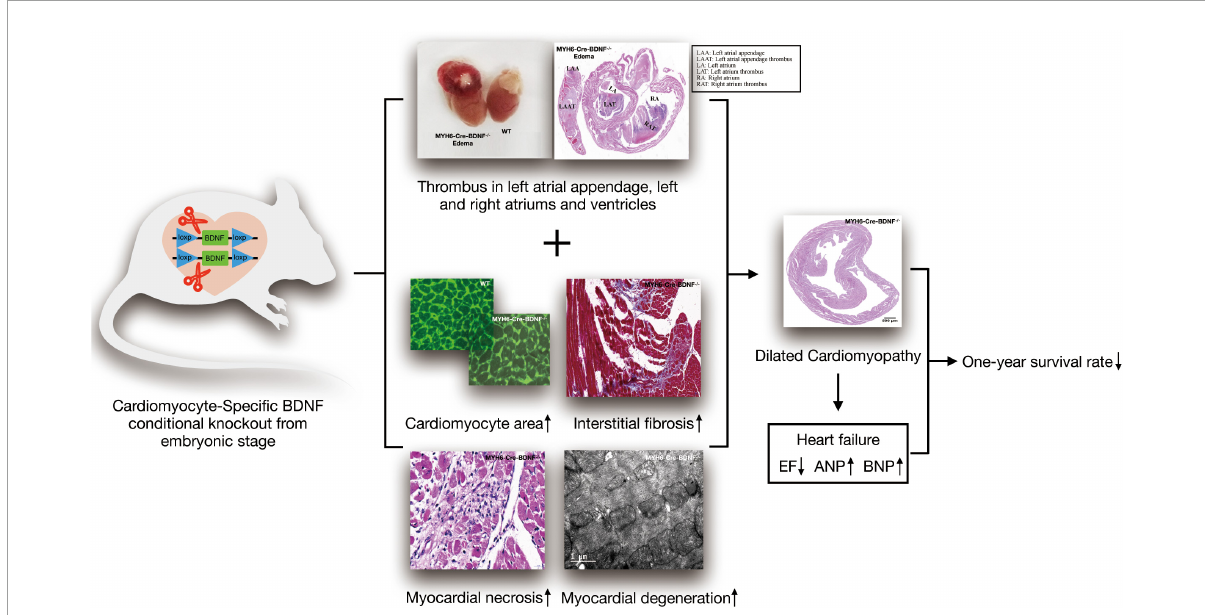
FIGURE8 Schematic diagram of the ablation of cardiomyocyte-derived BDNF during development resulting in cardiac degeneration pathology, heart failure and low one-year survival